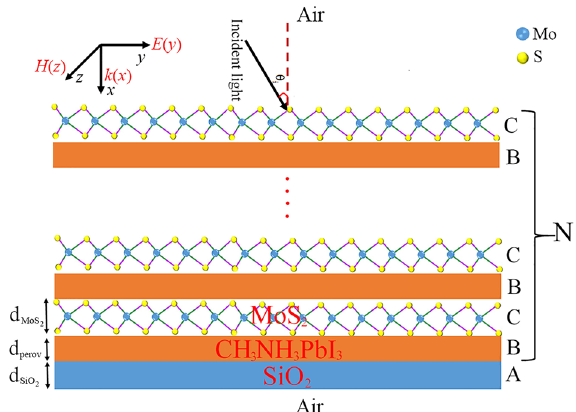
Figure 1. Schematic of the CH 3 NH 3 PbI 3 perovskite-based photonic crystal, in which a monolayer MoS 2 film is embedded between two CH 3 NH 3 PbI 3